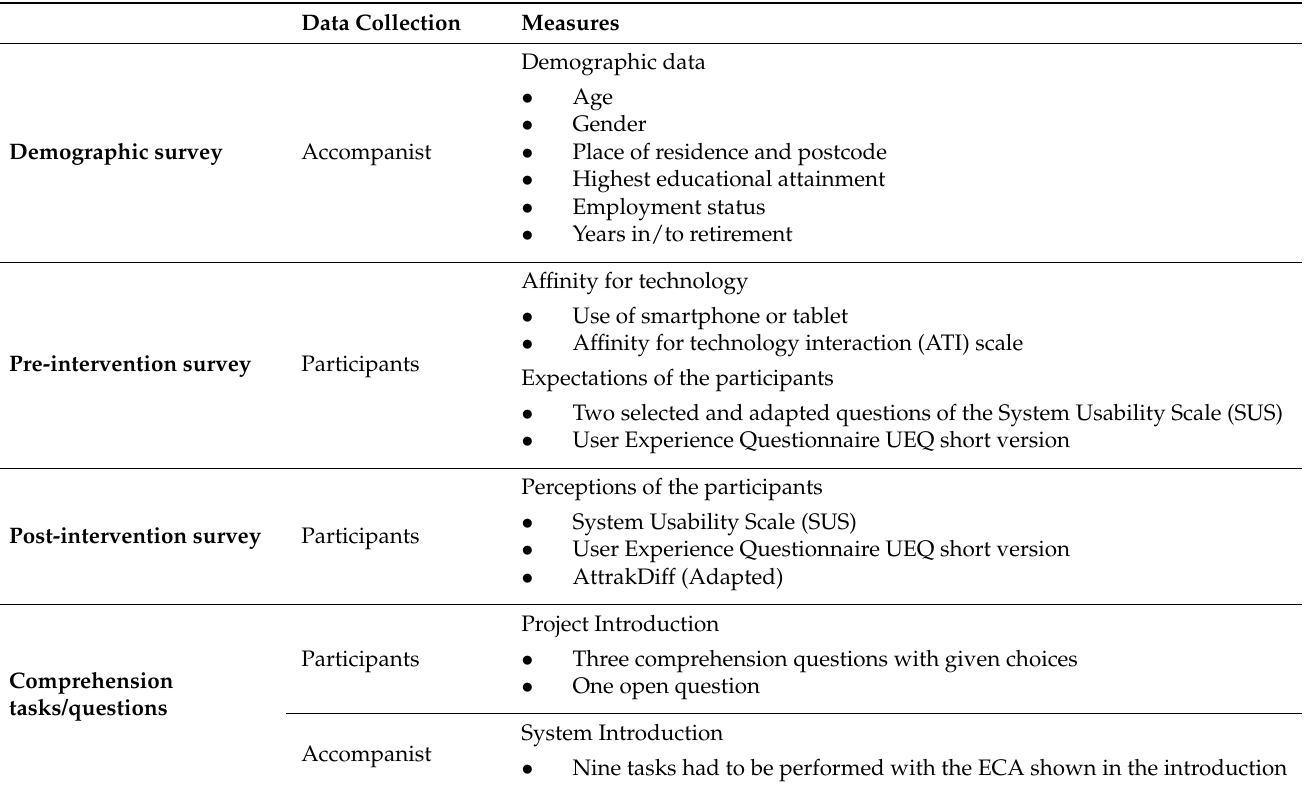
Table 1. Surveys and